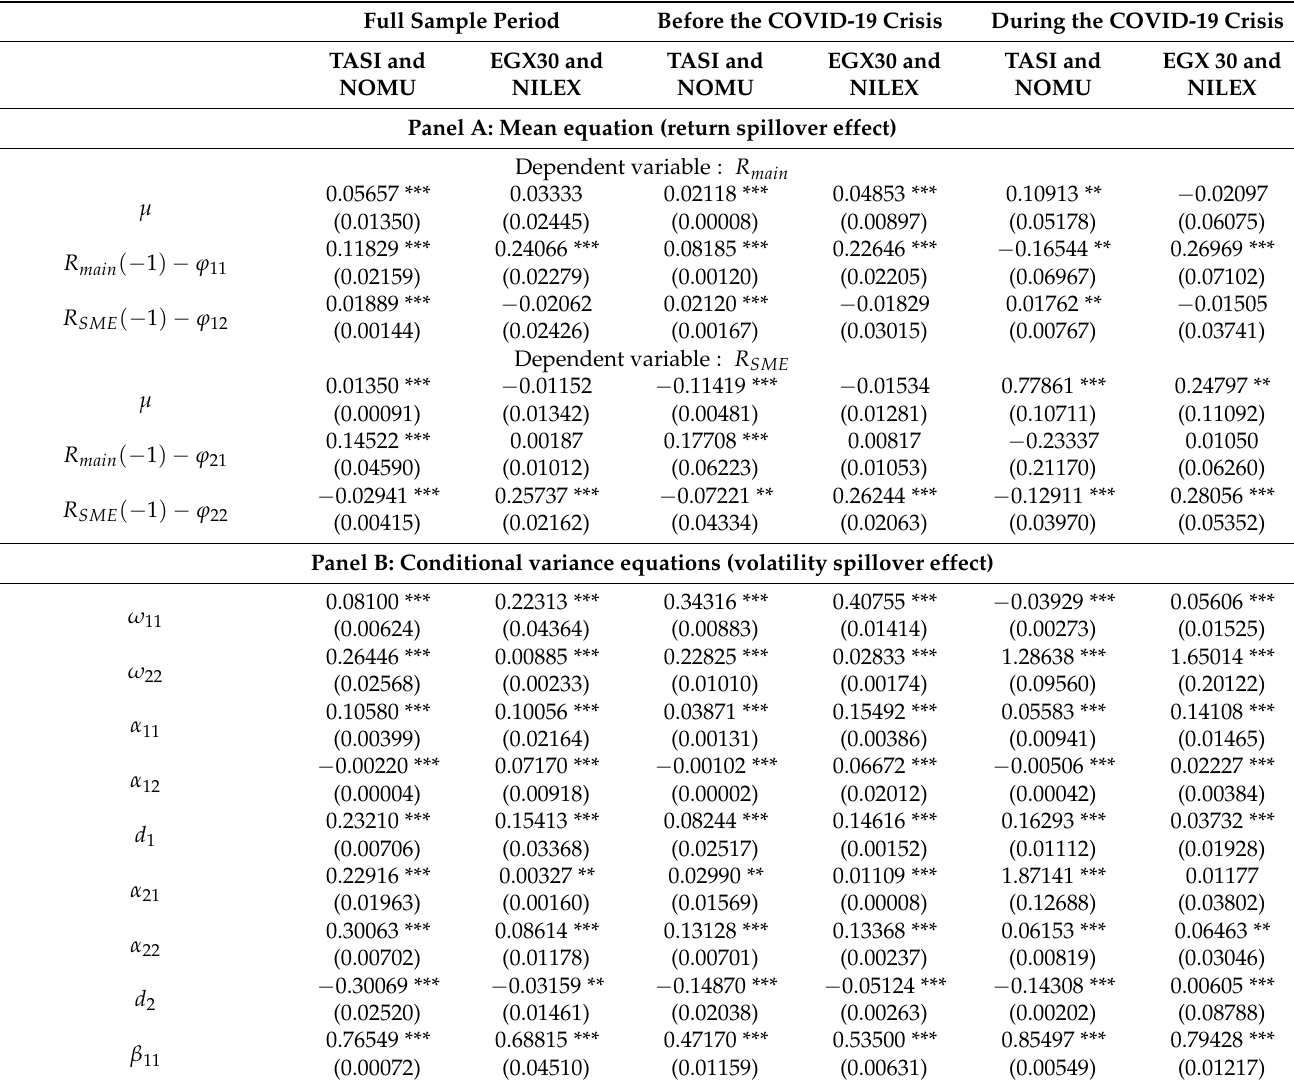
Table 5. Estimation results of the bivariate VAR (1)-asymmetric DCC–GARCH (1,1) model. Full Sample Period